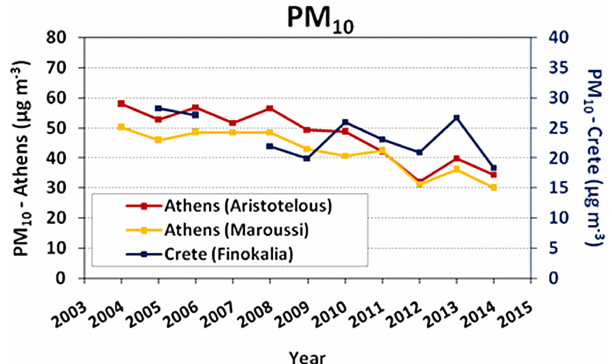
Figure 15. Variation of the annual PM 10 levels at the reference sta- tion of Finokalia (2005–2014) and at the stations of Maroussi and Aristotelous in Athens